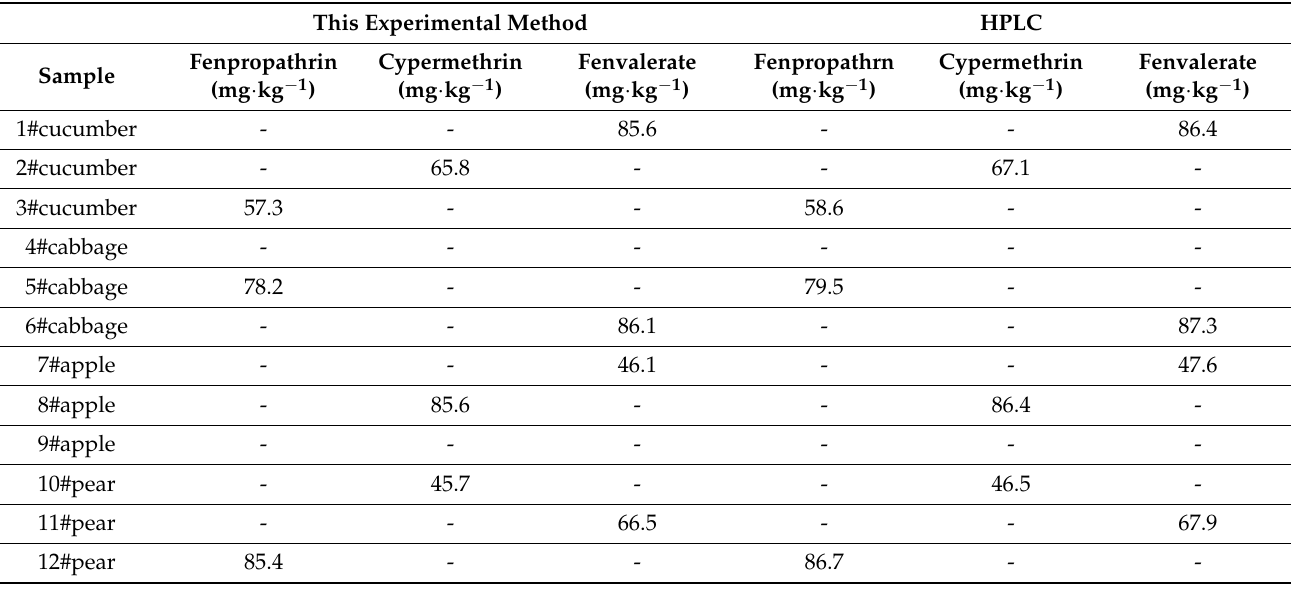
Table 2. Detection of pyrethroids in actual samples.